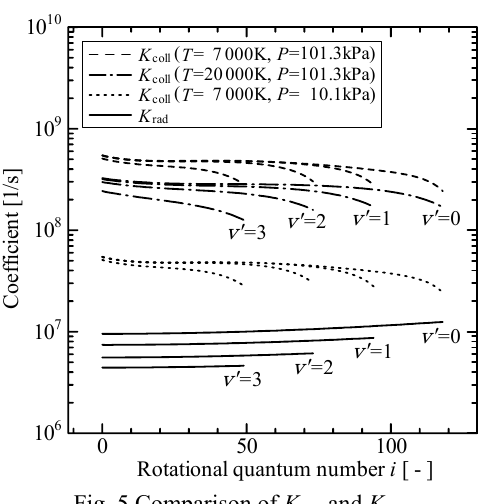
Fig. 5 Comparison of K